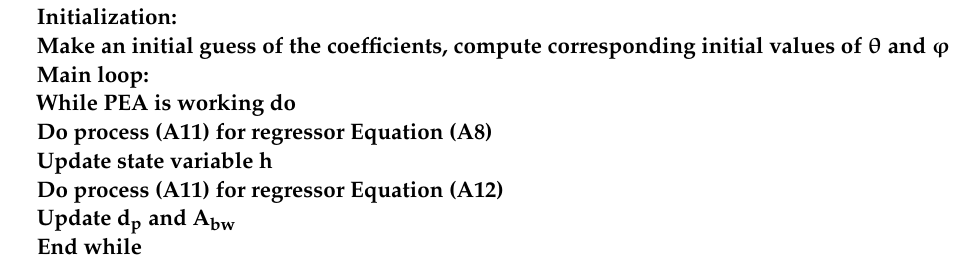
Algorithm A1 Parallel recursive least square algorithm for online parameter estimation. Parallel RLSE